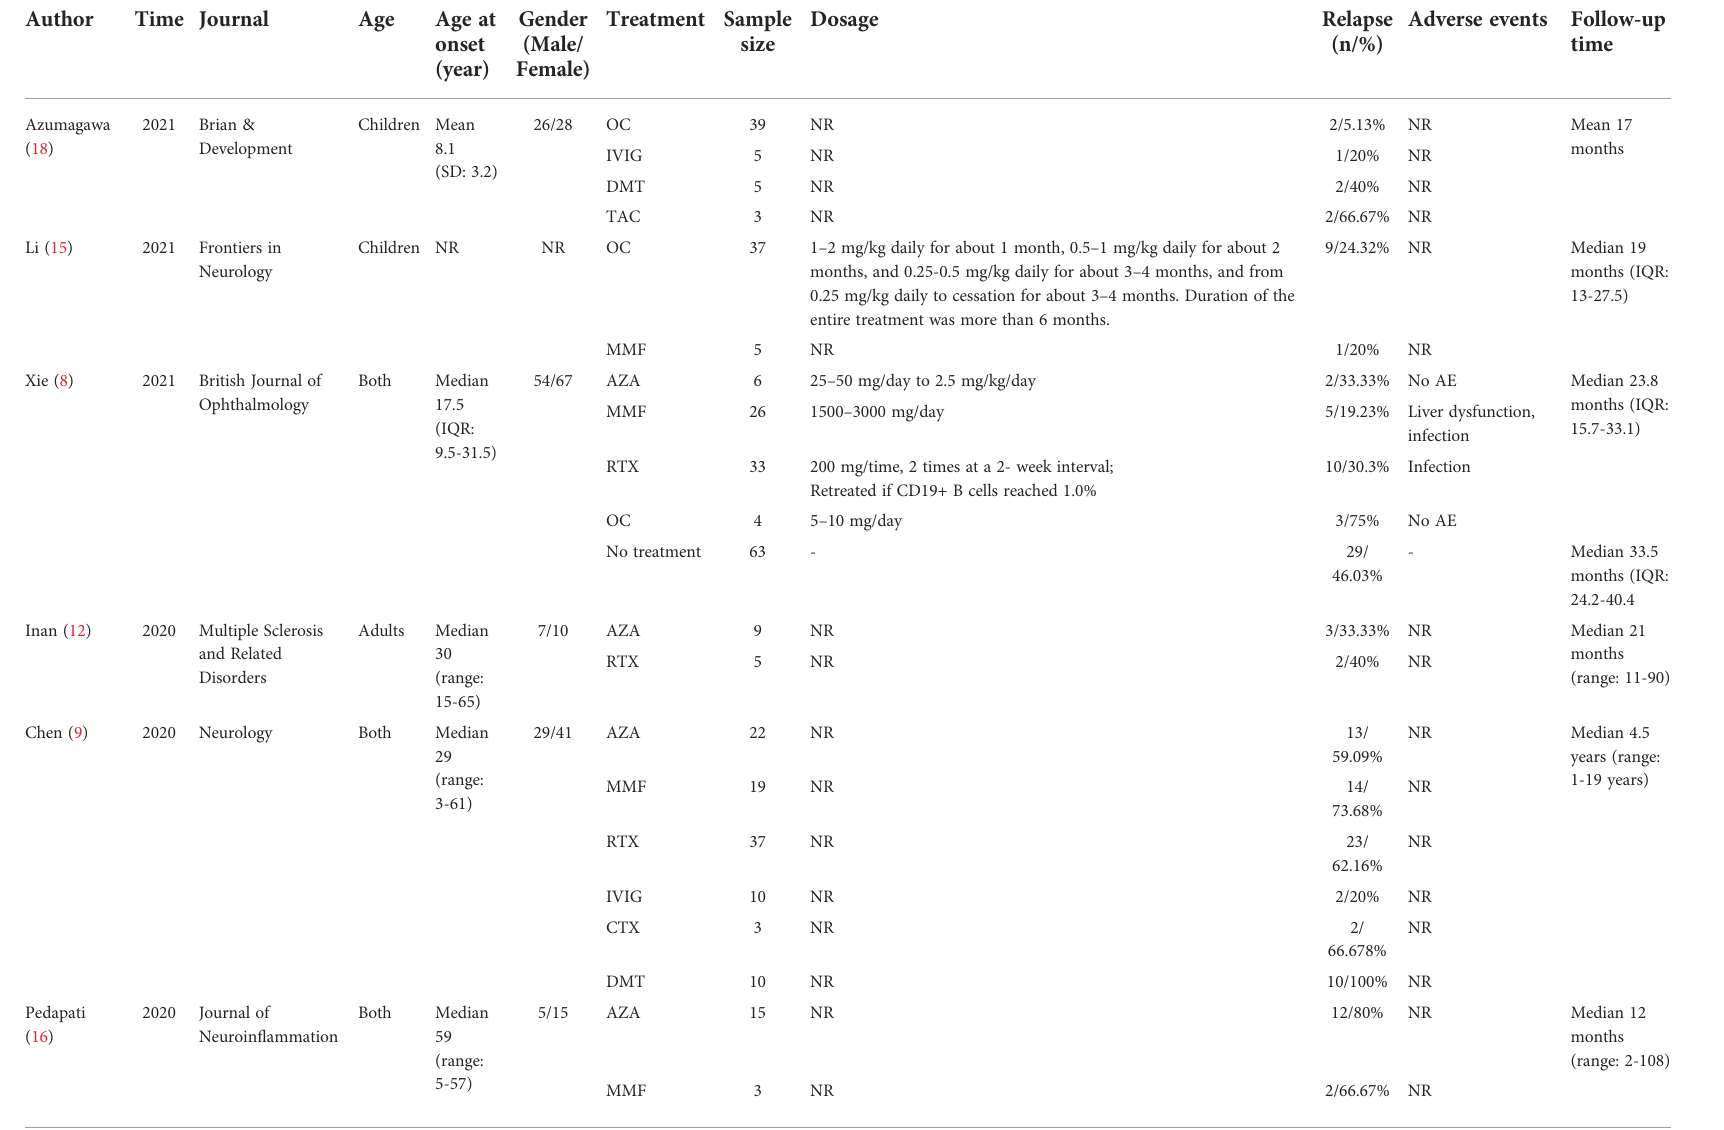
TABLE 1 Information of enrolled